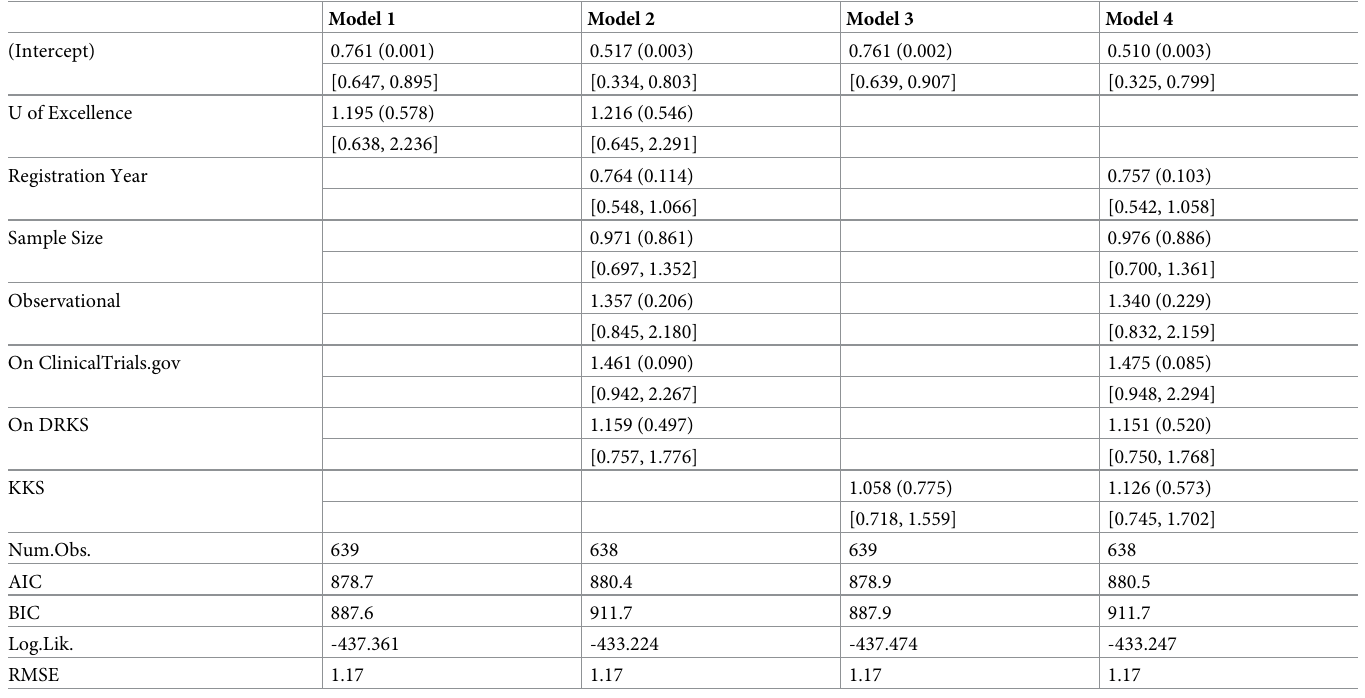
Table 9. Summary of logistic regression models of Odds-Ratios for article availability with p-values in parentheses and 95% confidence